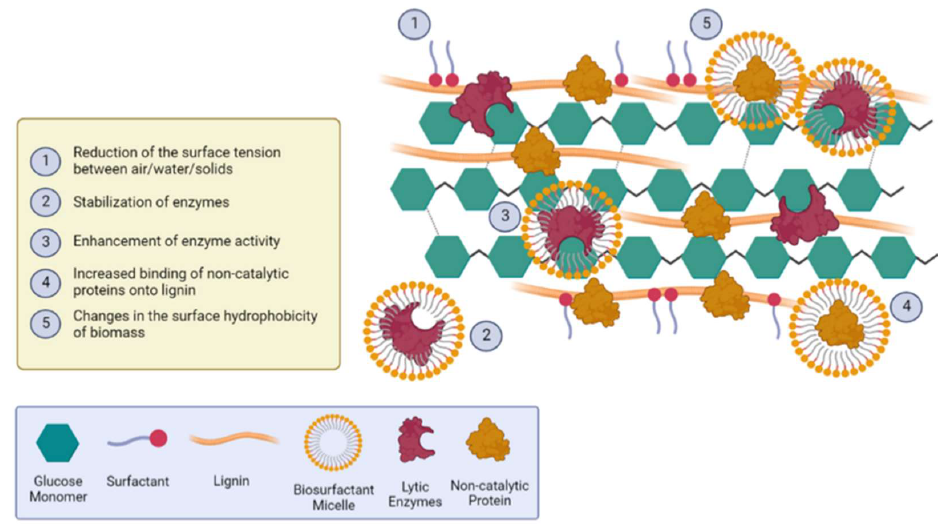
Figure 2. Schematic representation of the likely mechanisms occurring during the enzymatic hydrolysis of lignocellulosic biomasses supplemented with additive formulations composed of non-catalytic proteins, surfactants, and biosurfactants (Created with BioRender.com).